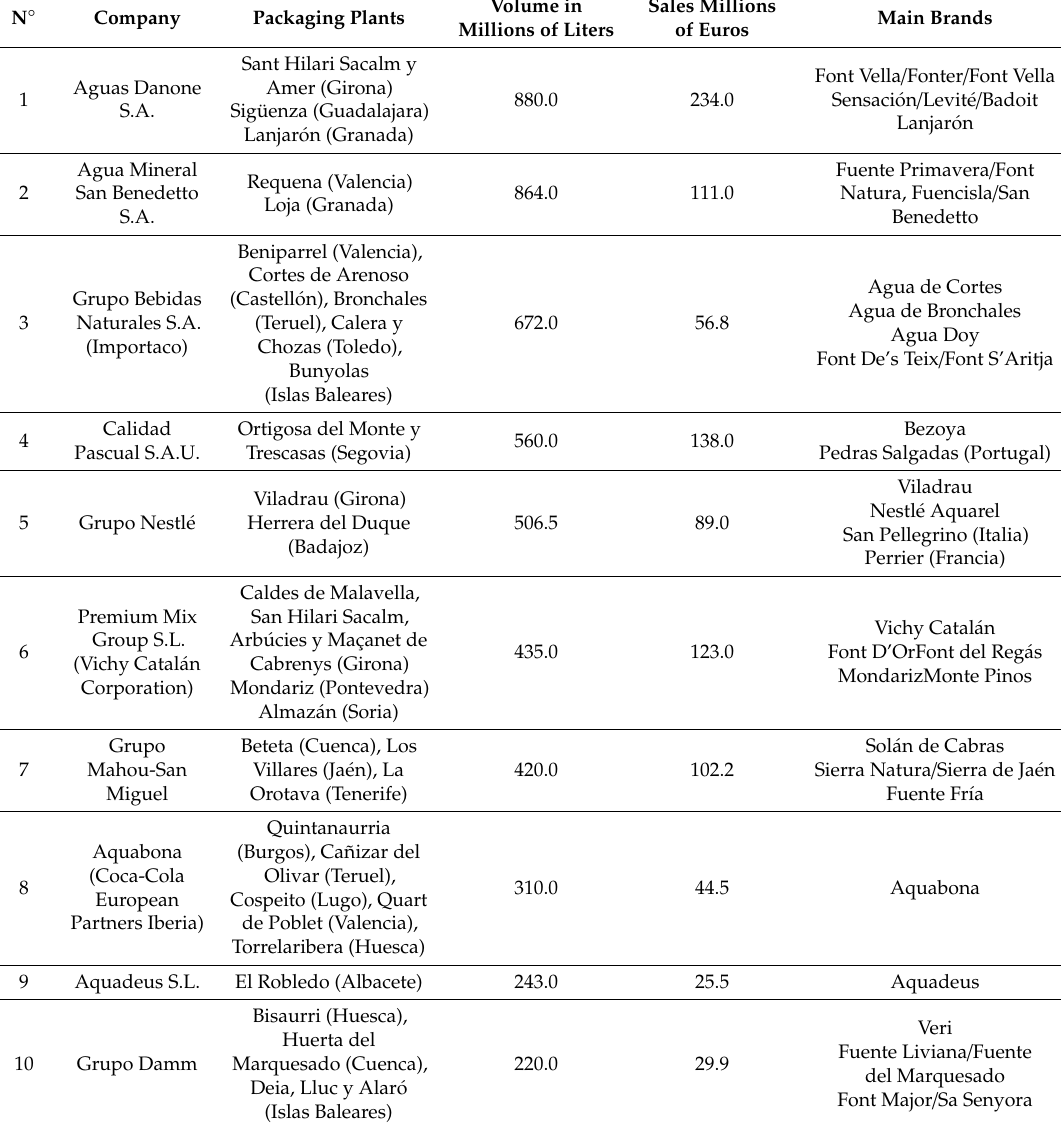
Table A3. Main water bottling companies in Spain for the year 2018. Source: Heras